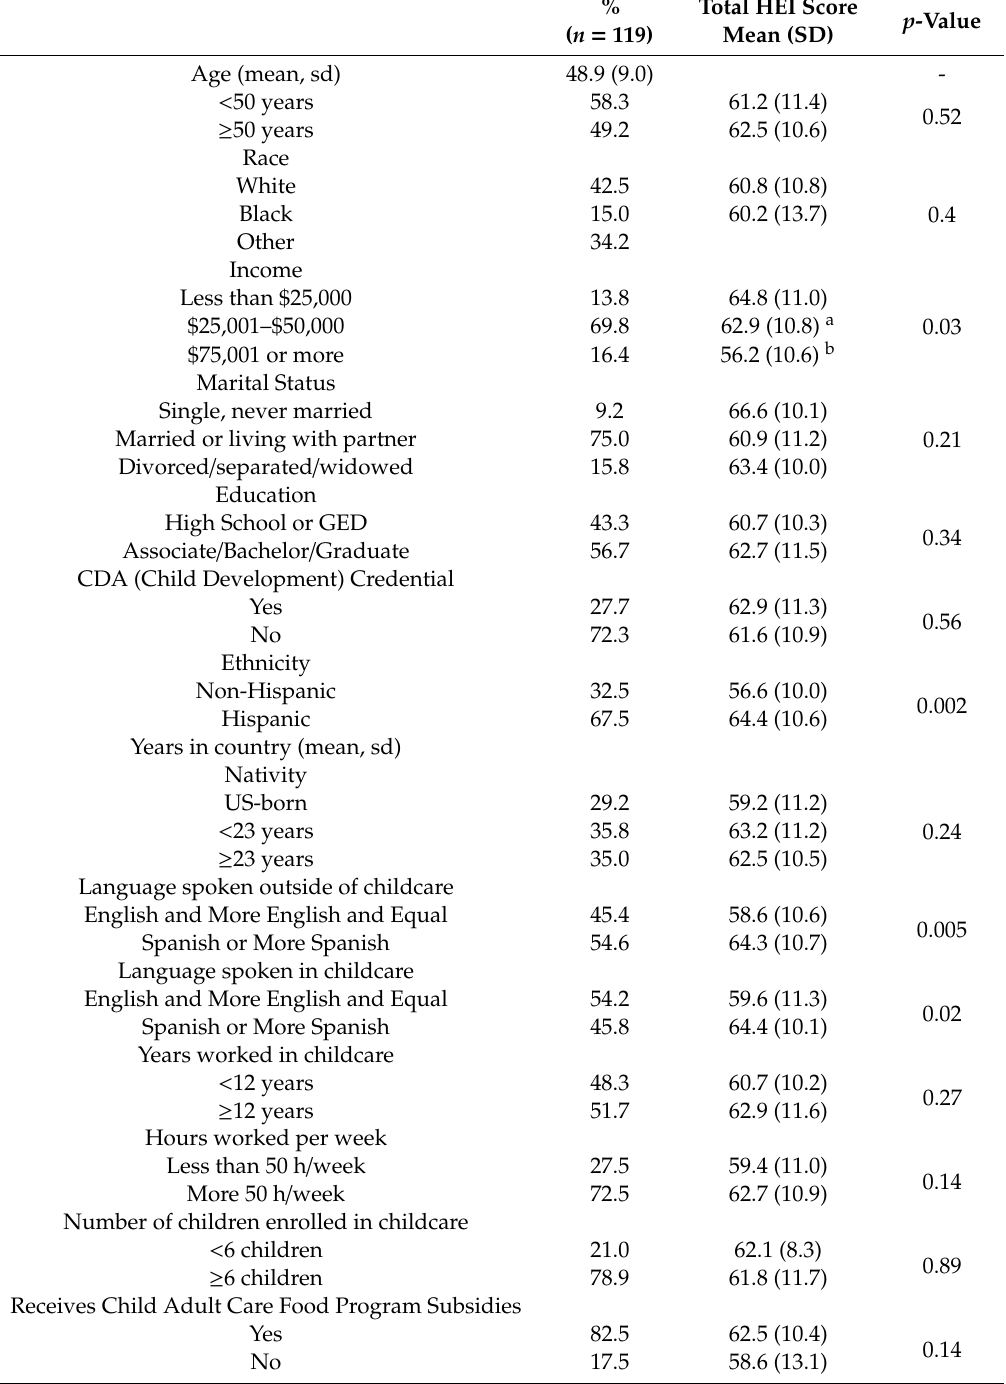
Table 1. Demographic Characteristics for 119 family childcare homes (FCCH) by mean Healthy Eating Index (HEI)-2015